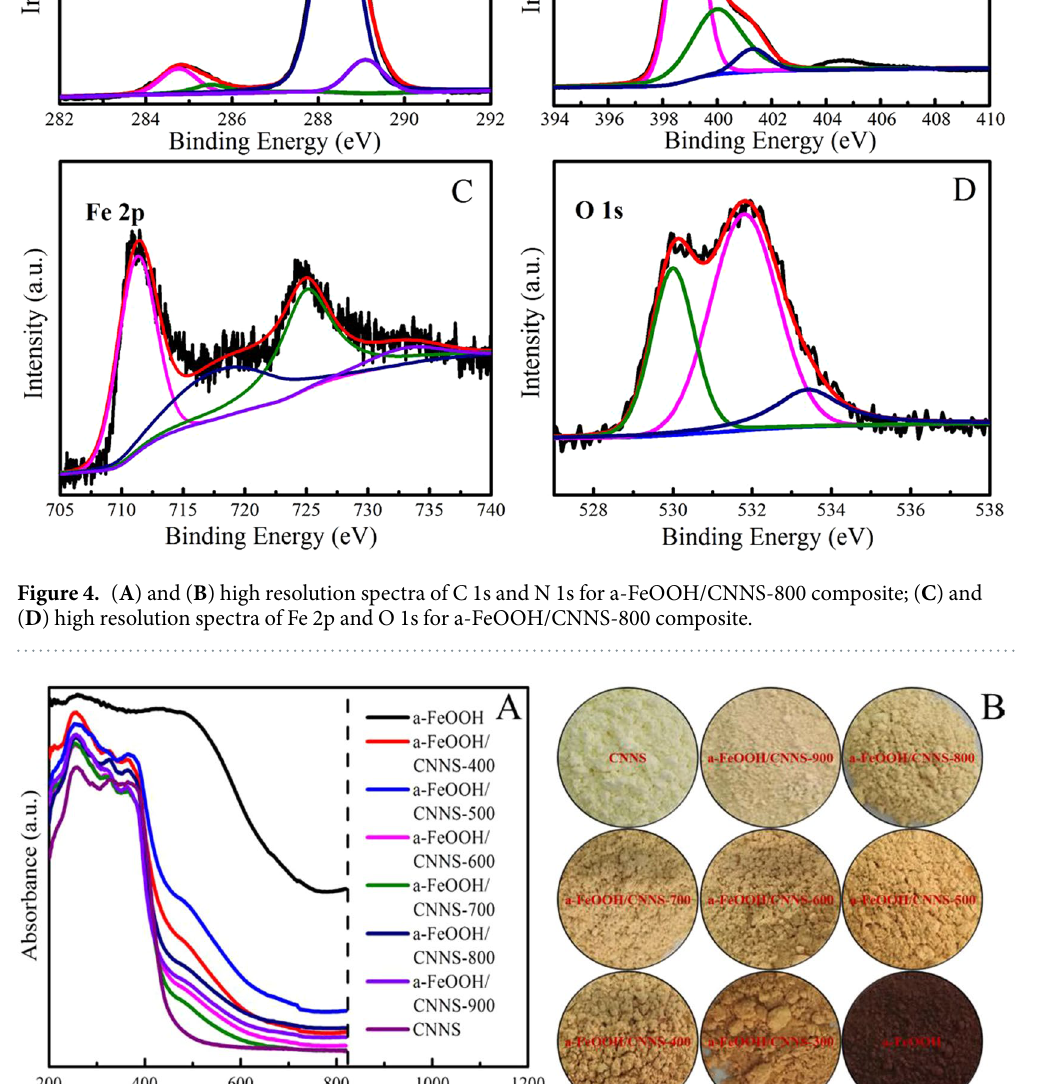
The energy levels and band gap of semiconductor photocatalysts play a crucial role in determining photocata- lytic performance. The band gap energy (E g ) of a semiconductor can be calculated by the following Eq.: n /2 ν α ν = − ( ) h h A E g where α , h, ν , E g and A represent the light absorption coefficient, Planck constant, light frequency, band gap energy, and constant, respectively. Among them, n is determined by the type of optical transition of a semicon- ductor (n = 1 for direct transition and n = 4 for indirect transition). The band gaps are estimated to be 2.56 eV and 0.91 eV for CNNS and a-FeOOH respectively (Figure S3), according to a plot of ( α h ν ) 1/2 versus energy (h ν ).